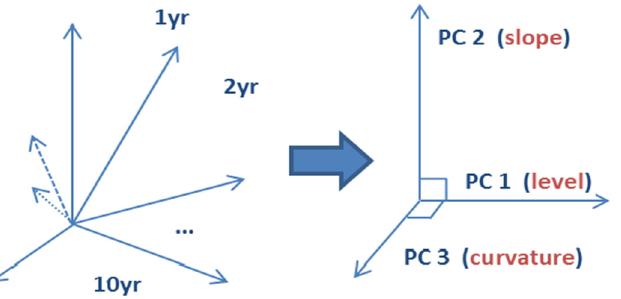
Figure 1. Orthogonalization transformation of interdependent interest rates into uncorrelated prin- cipal components.